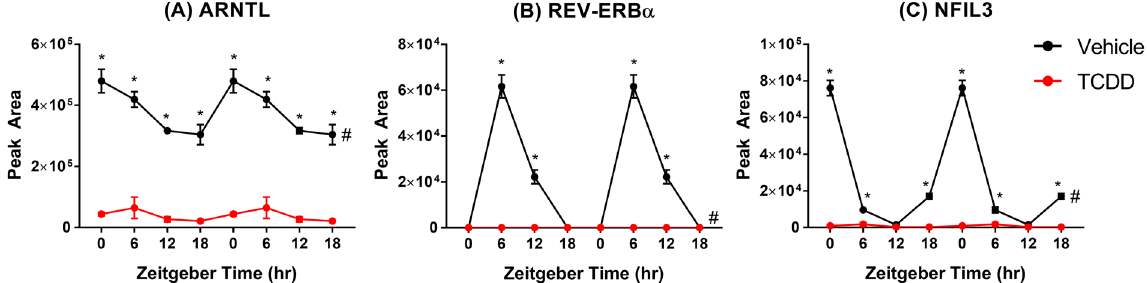
Figure 5. Hepatic protein levels of ( A ) ARNTL, ( B ) REV-ERB α , and ( C ) NFIL3 in male C57BL/6 mice orally gavaged with sesame oil vehicle or 30 µ g/kg TCDD every 4 days for 28 days. Data points represent the average of 3 individual mice ± standard error of the mean measured using capillary electrophoresis (WES ProteinSimple System). Statistical significance ( * p ≤ 0.05) between vehicle and TCDD was determined using a two-way